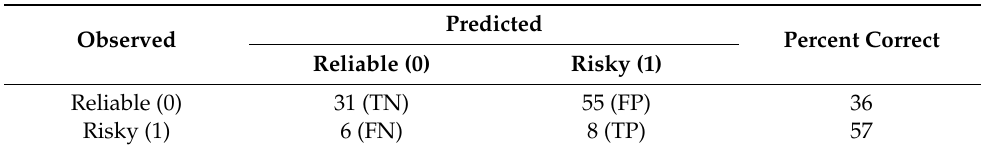
Table 8. Confusion matrix: prediction frequencies of risky and reliable borrowers based on the R-model.